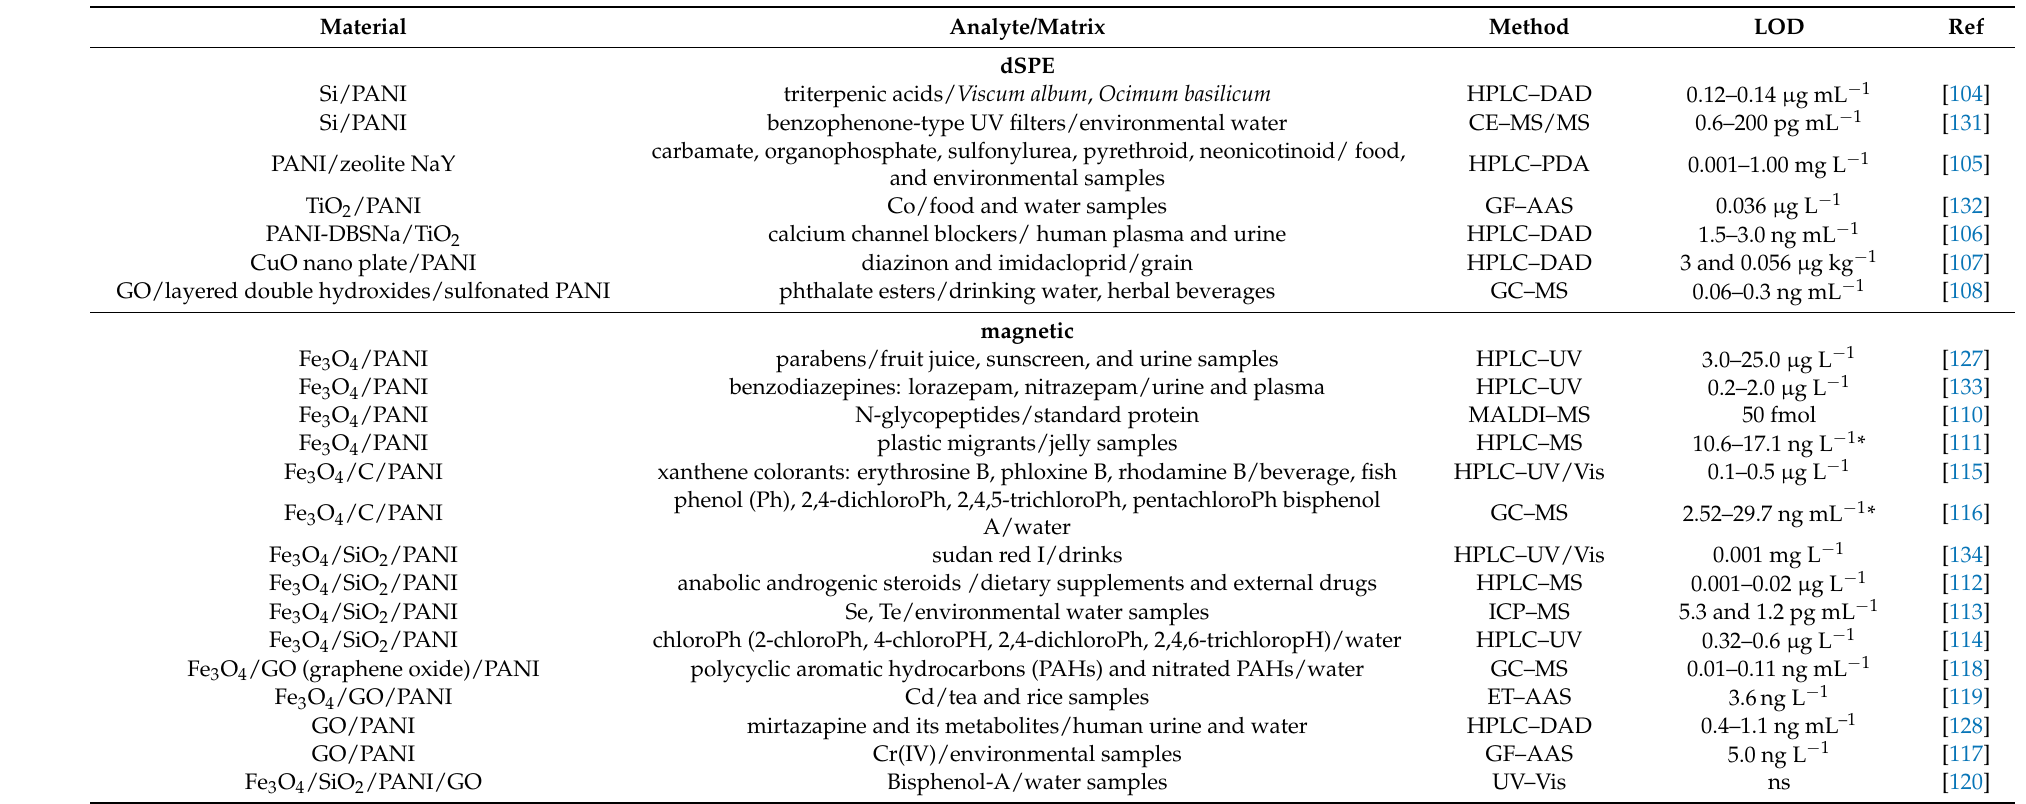
Table 4. Application of polyaniline and polyaniline composites in